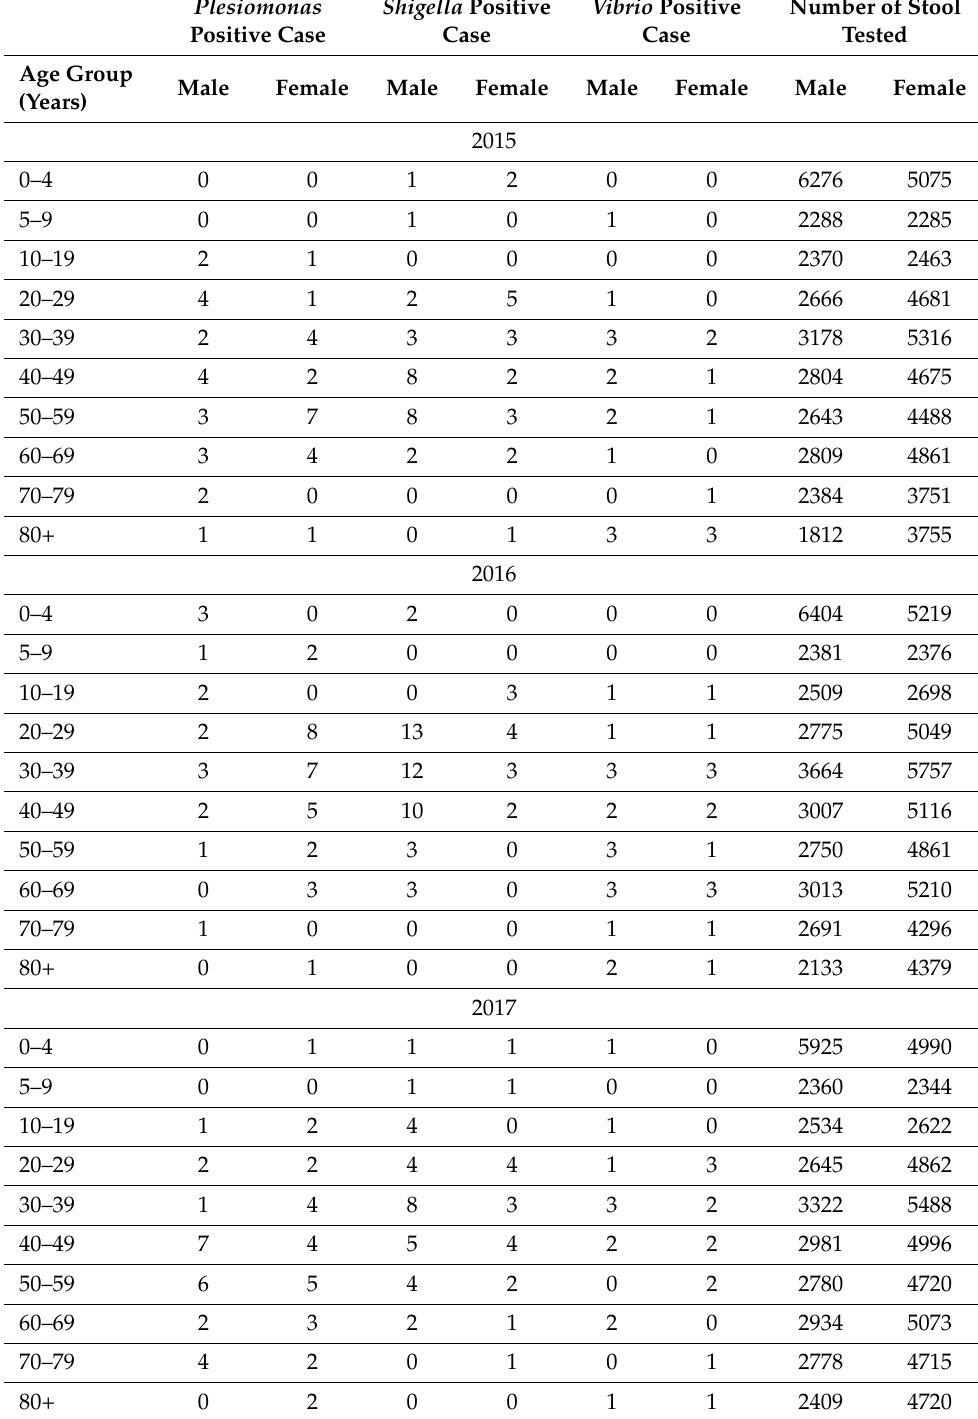
Table 4. Isolation of Plesiomonas shigelloides , Shigella and Vibrio species in individual years, from 2015 to 2019, in different age